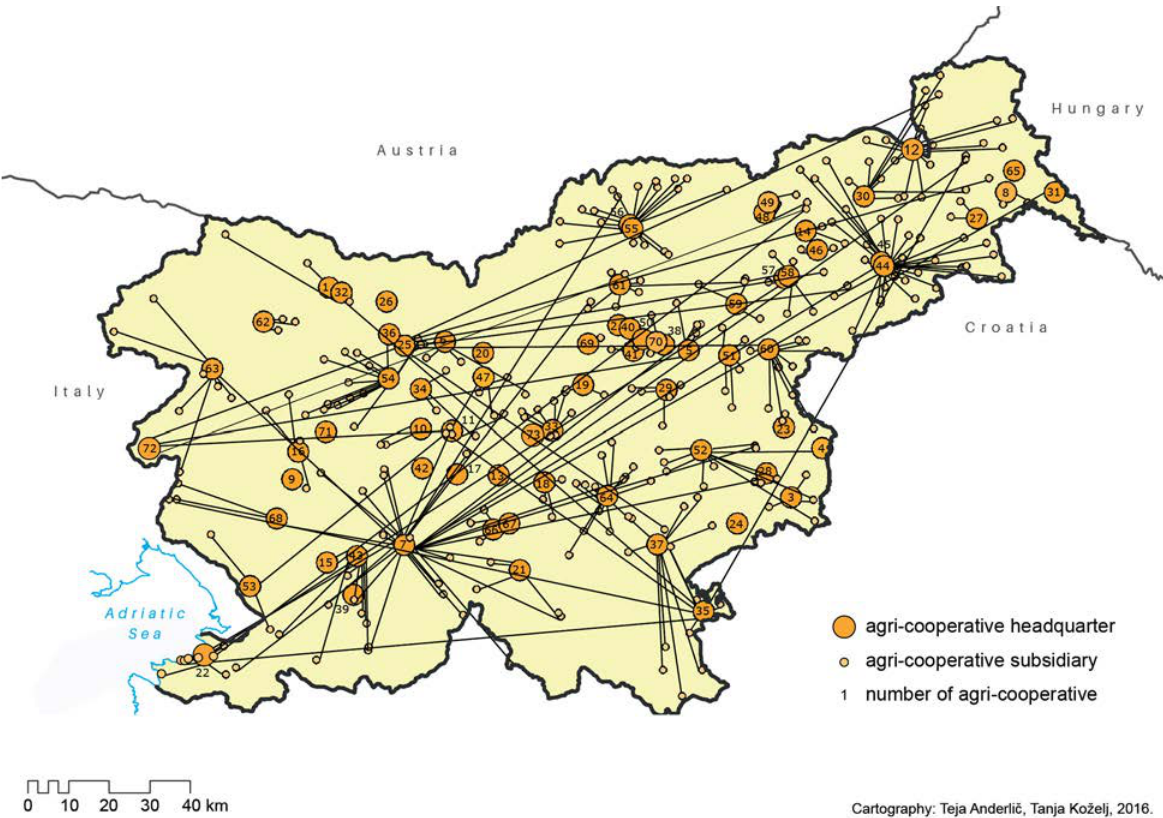
Fig. 2. Agri-cooperatives in Slovenia (headquarters and their